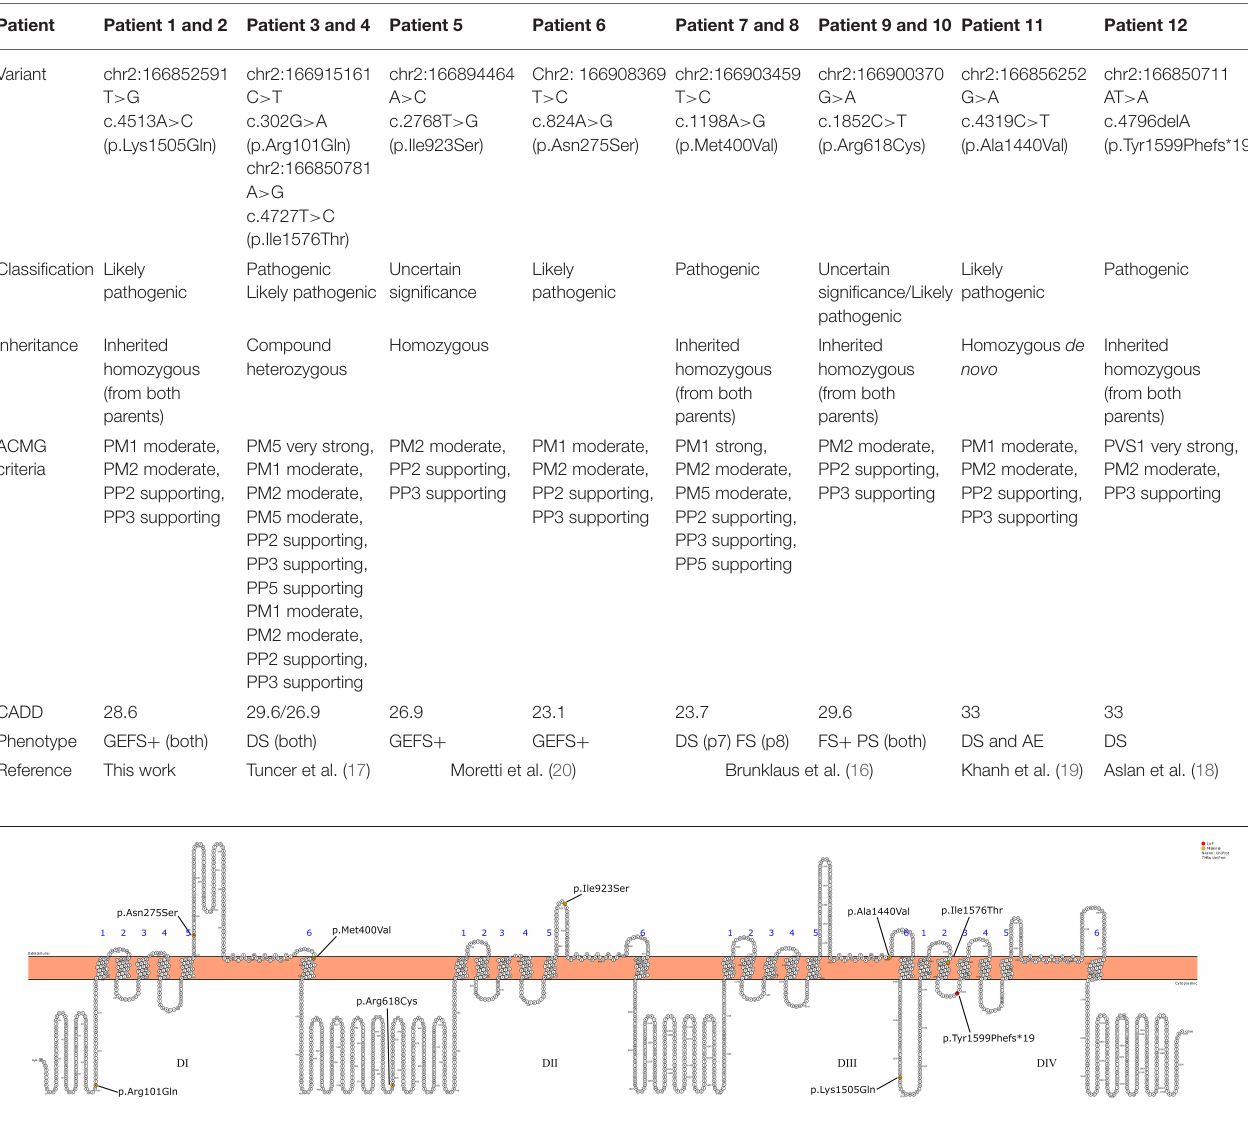
FIGURE 2 | Schematic representation of the SCN1A gene mutations detected in the 12